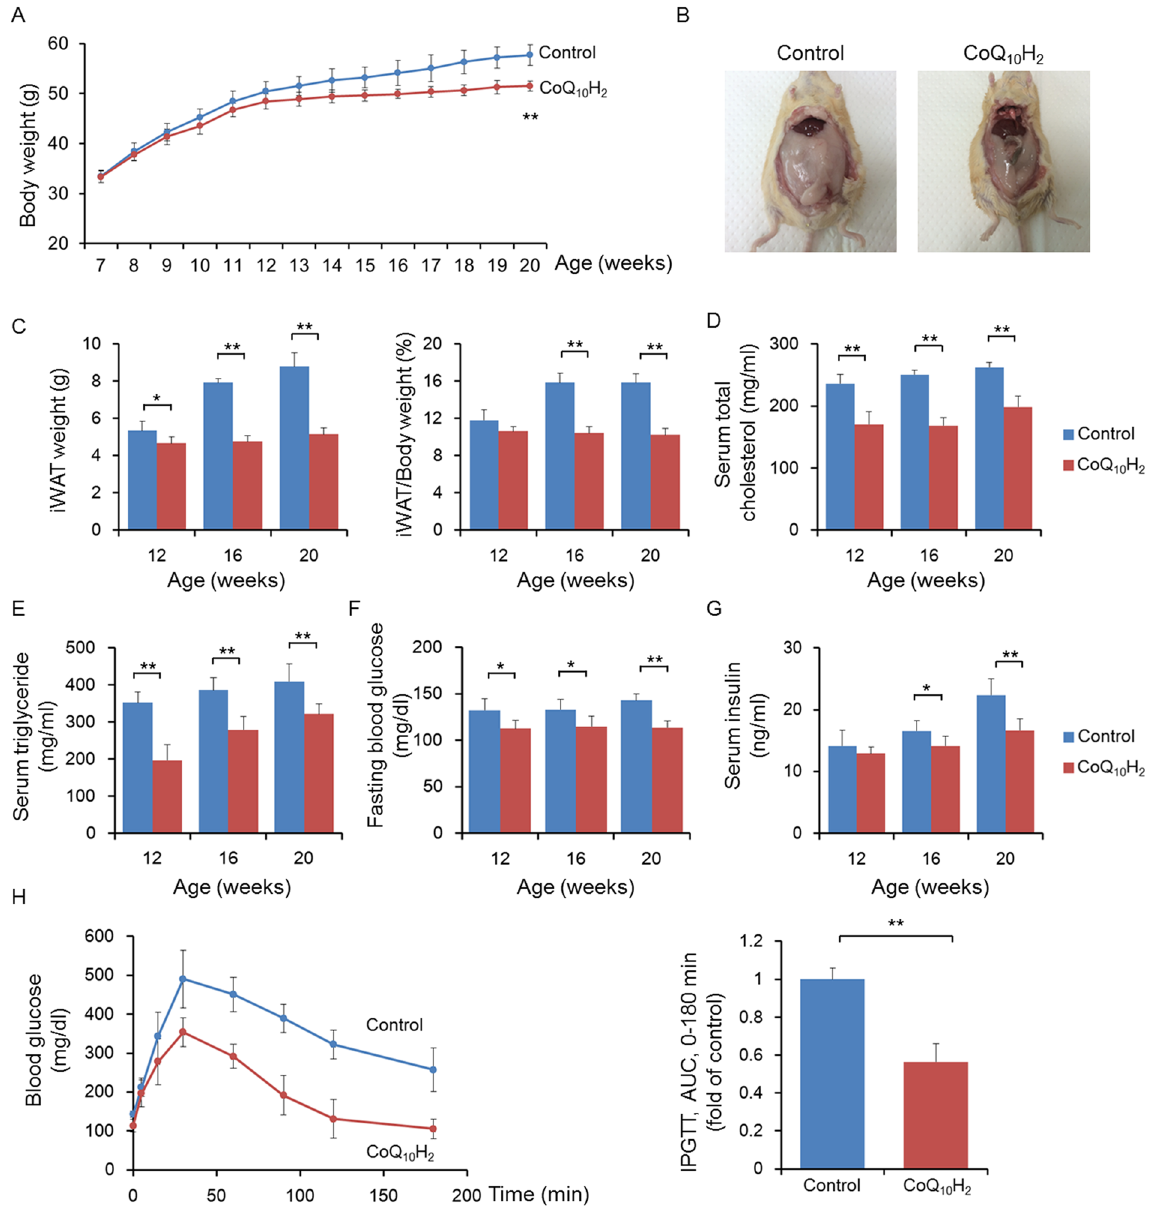
Figure 1. CoQ 10 H 2 prevented the accumulation of visceral fat (iWAT) in KKAy mice and protected mice from insulin resistance and metabolic disorders. ( A – C ) Body weight and iWAT content changes for animals in the control and CoQ 10 H 2 groups. Photographs show representative gross morphology of an iWAT mouse aged 20 weeks (n = 4–6, ∗ p < 0.05, ∗∗ p < 0.01; mean ± SD, Student’s t-test); ( D – G ) Serum cholesterol and triglyceride, fasting blood glucose and serum insulin levels of KKAy mice after 12 hours of fasting in each group at age 12, 16, and 20 weeks. (n = 4–6, ∗ p < 0.05, ∗∗ p < 0.01; mean ± SD, Student’s t-test); ( H ) Changes in blood glucose and area under the curve (AUC) in 20-week-old mice after intraperitoneal injection of glucose (1 g/kg body weight) following 12 hours of fasting. (n = 4–6, ∗ p < 0.05, ∗∗ p < 0.01; mean ± SD, Student’s